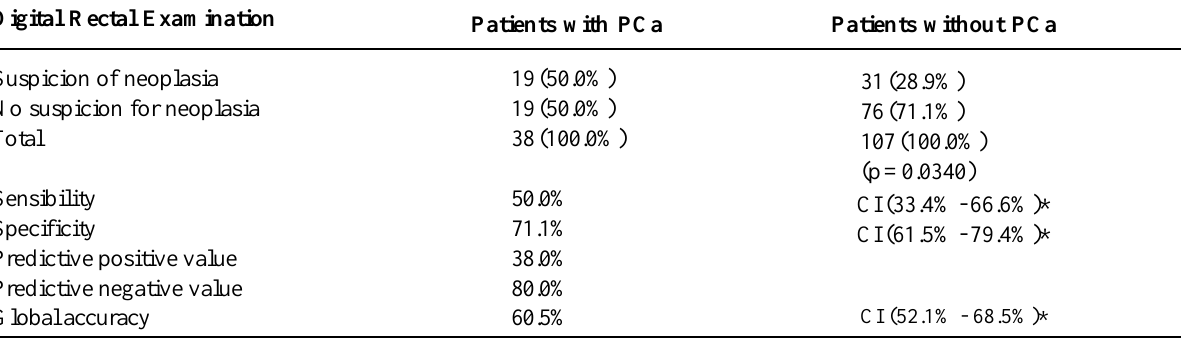
Table 3 – Relation between the digital rectal examination with suspicion of neoplasia and the PCa